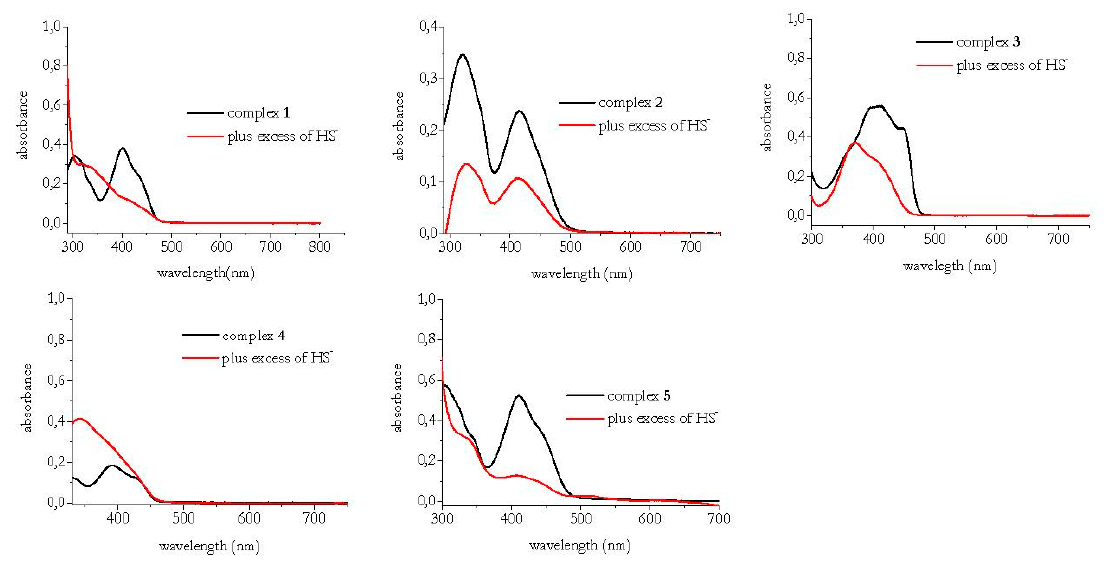
Figure 1. Electronic absorption spectra of complexes 1 − 5 with and without the addition of 50 µM of NaSH. Spectra recorded in DMSO. [complexes] = 10 µM.